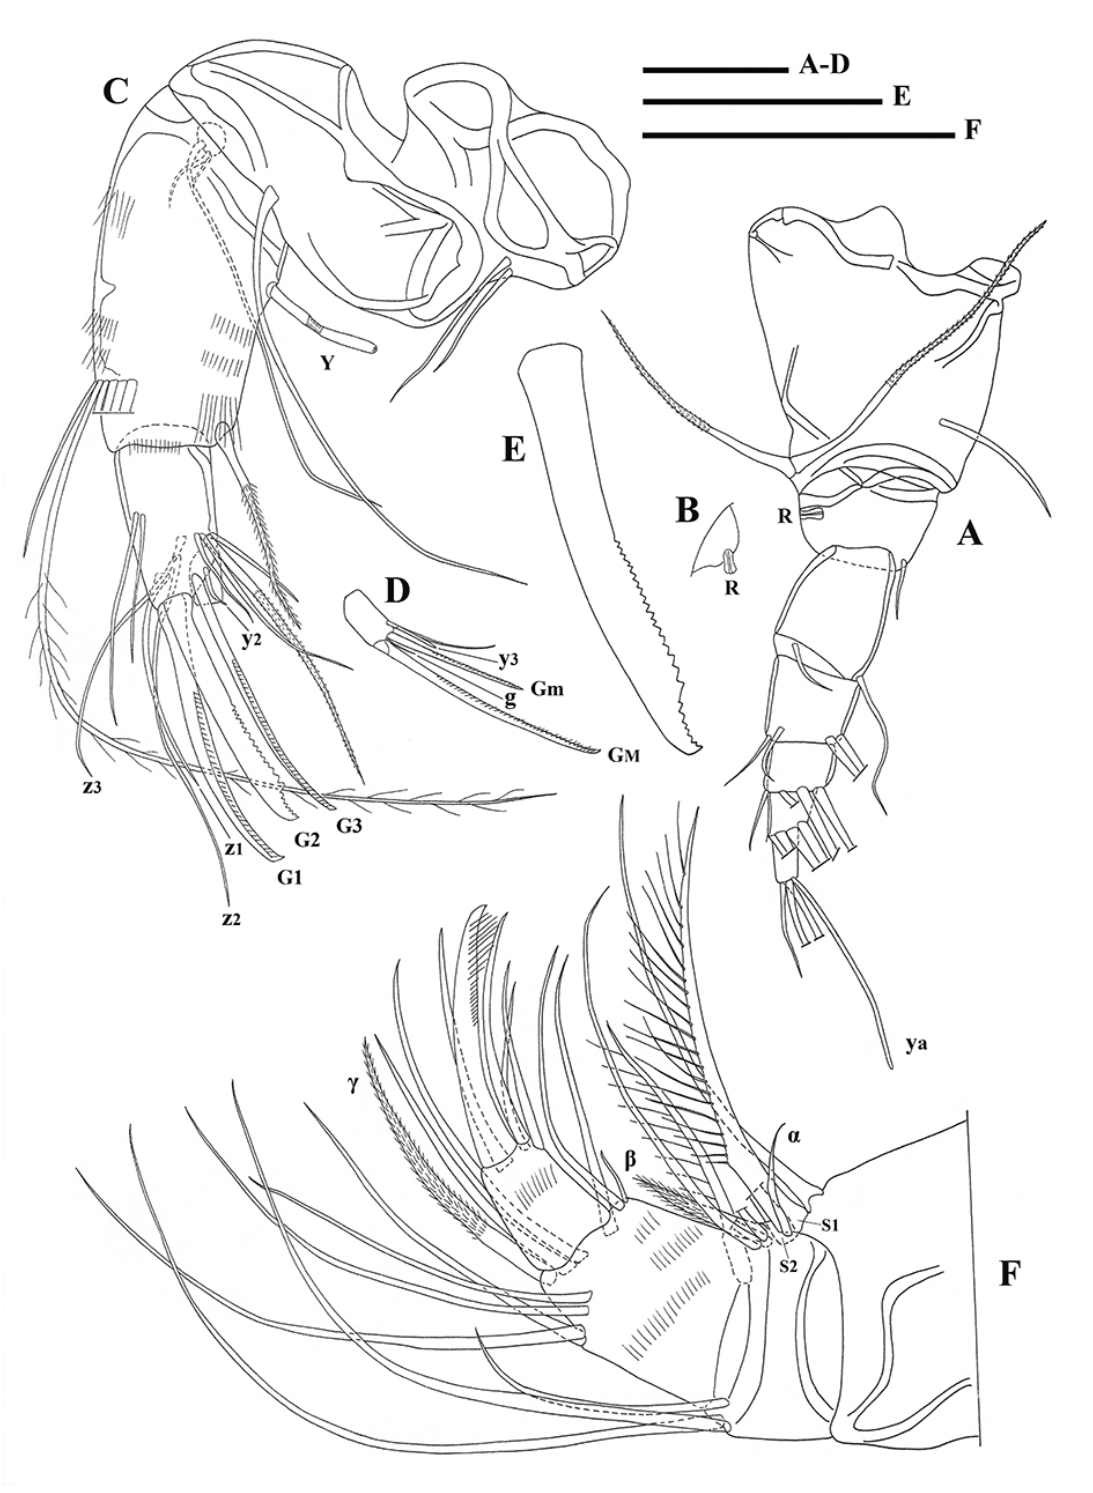
Fig. 2. Thaicypridopsis longispinosa sp. nov., ♀♀. A. A1 (MSU-ZOC.264). B. Rome organ of A1 (MSU-ZOC.257). C. A2 (idem). D. Distal segment of A2 (idem). E. Claw G2 of A2 (idem). F. Md-palp (MSU-ZOC.263). Scale bars: 50